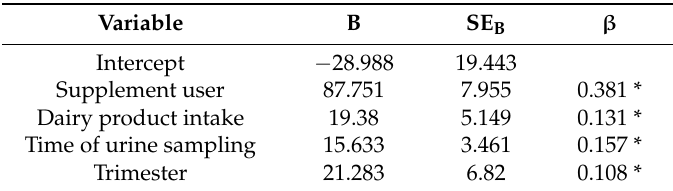
Table 5. Predictors of urinary iodine to creatinine ratio (UI/Cr) in pregnant women with UI/Cr ( µ g iodine/g creatinine) as dependent